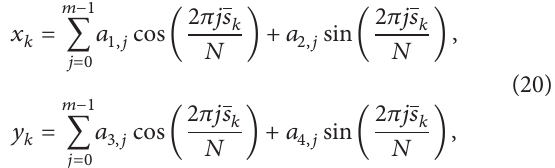
Figure 13: A twist perturbation. Notice that if the twist is applied precisely at a global max of the turning angle (as measured by the tangent here and the one lagging it in 𝑠 ), we will increase the turning angle there and will end up with a unique global